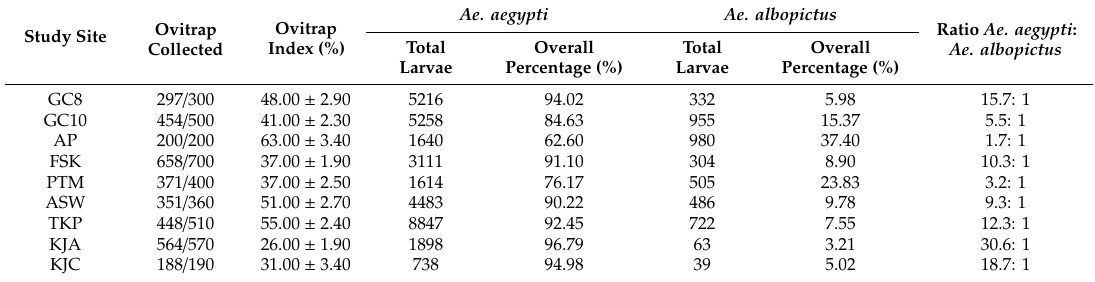
Table 2. The overall analysis of Aedes larval instars collected in each study